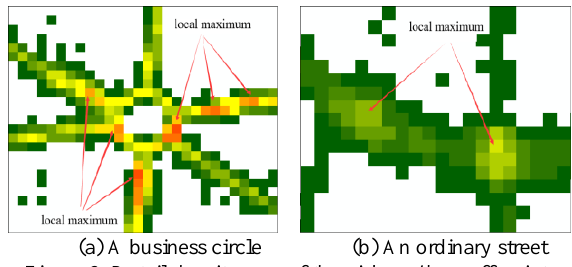
Figure 2. Detail density map of the pick-up/drop-off